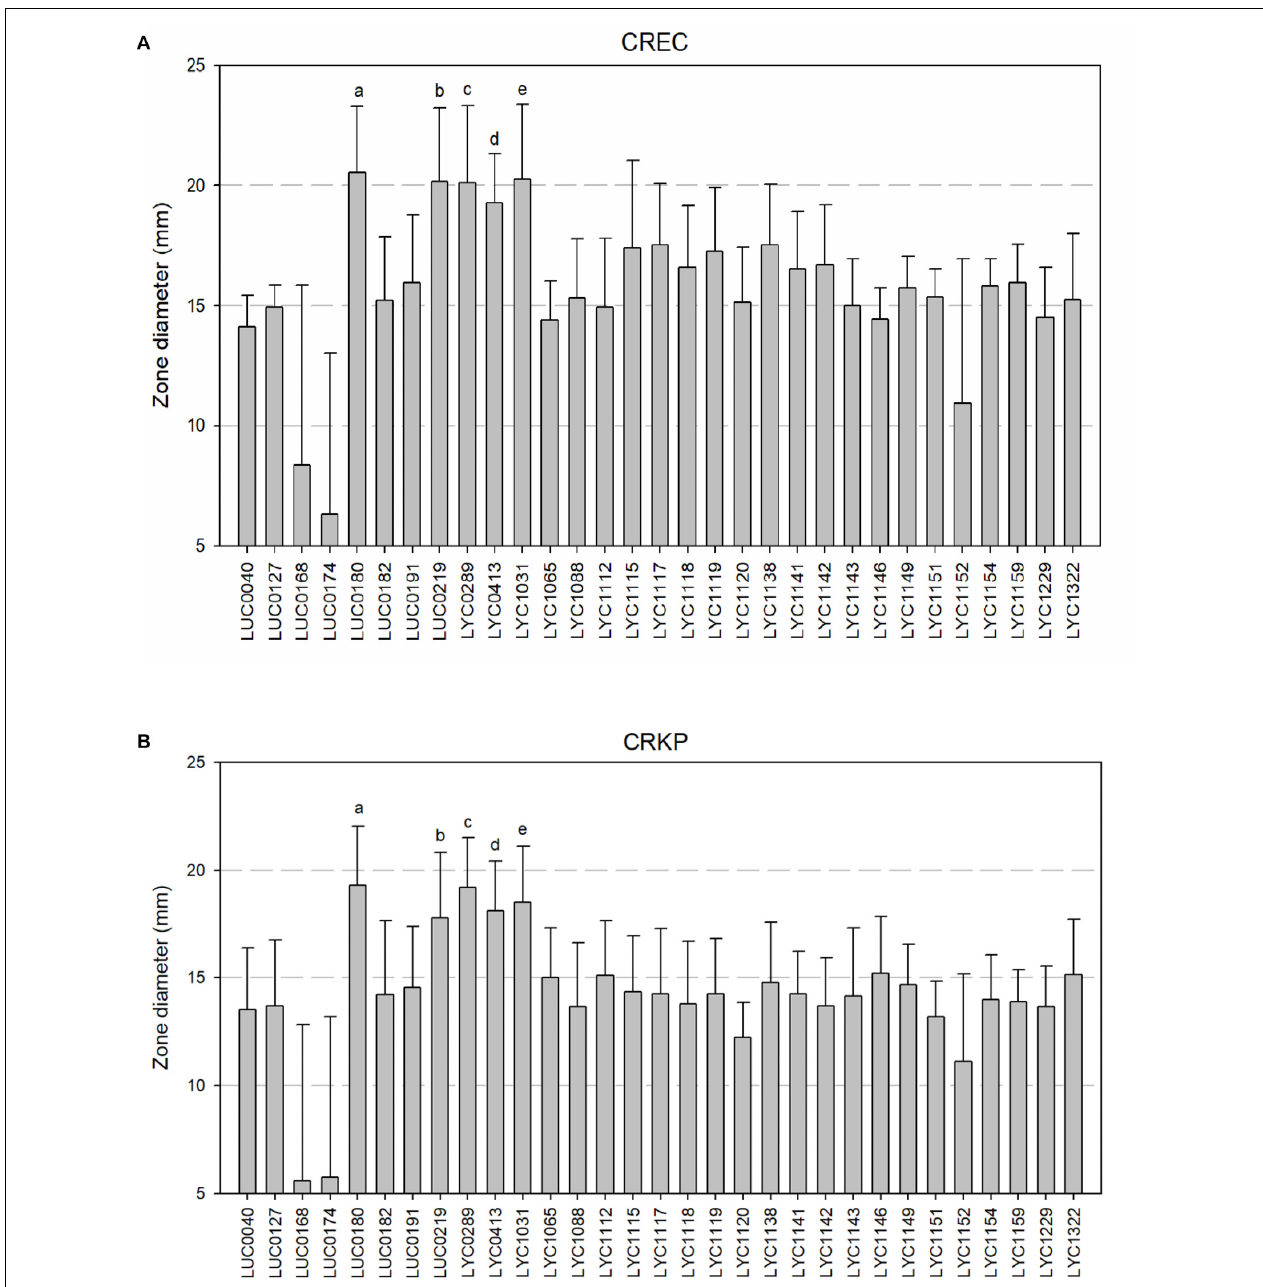
FIGURE 2 | (A) Zone of inhibition of 31 Lactobacillus isolates against carbapenem-resistant E. coli by well diffusion assays. (a, b, c, d, e five isolates showed the significantly better activity than all of the other strains (all p < 0.05). However, there was no significant differences among them). (B) Zone of inhibition of 31 Lactobacillus isolates against carbapenem-resistant K. pneumoniae by well diffusion assays. [a, b, c, d, e five isolates showed the significantly better activity than all of the other strains (all p < 0.05). However, there was no significant differences among